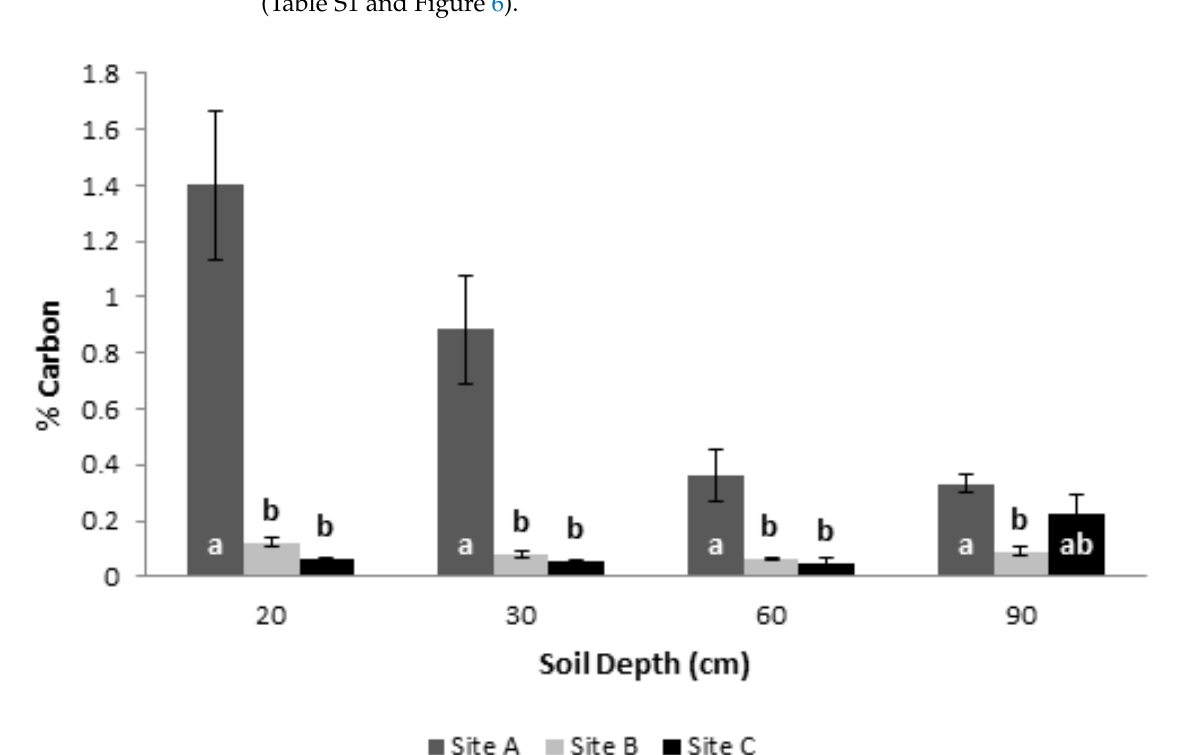
Figure 6. Soil carbon percentage from samples collected at different soil depths (20, 30, 60, and 90 cm), in three slash pine plantations featuring different ages. Site A: 14-, Site B: 24-, Site C: 26-year-old plantations (age at the installation of the experiments). Each mean was calculated with ten combined samples from the same soil layer. Bars sharing a letter are not significantly different by the Tukey test ( p ≤ 0.05).